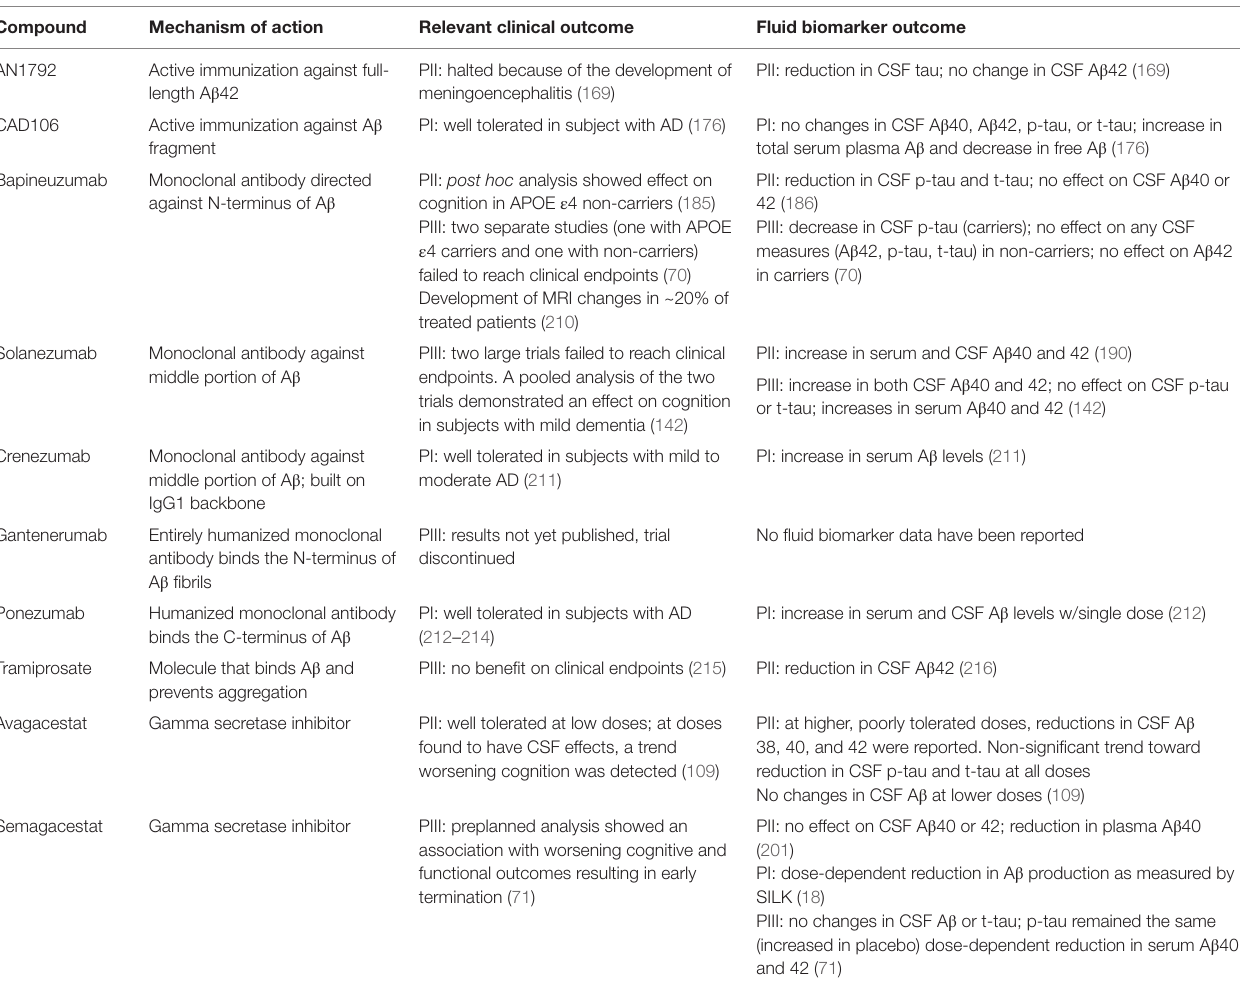
TABLe 3 | Fluid biomarkers in clinical